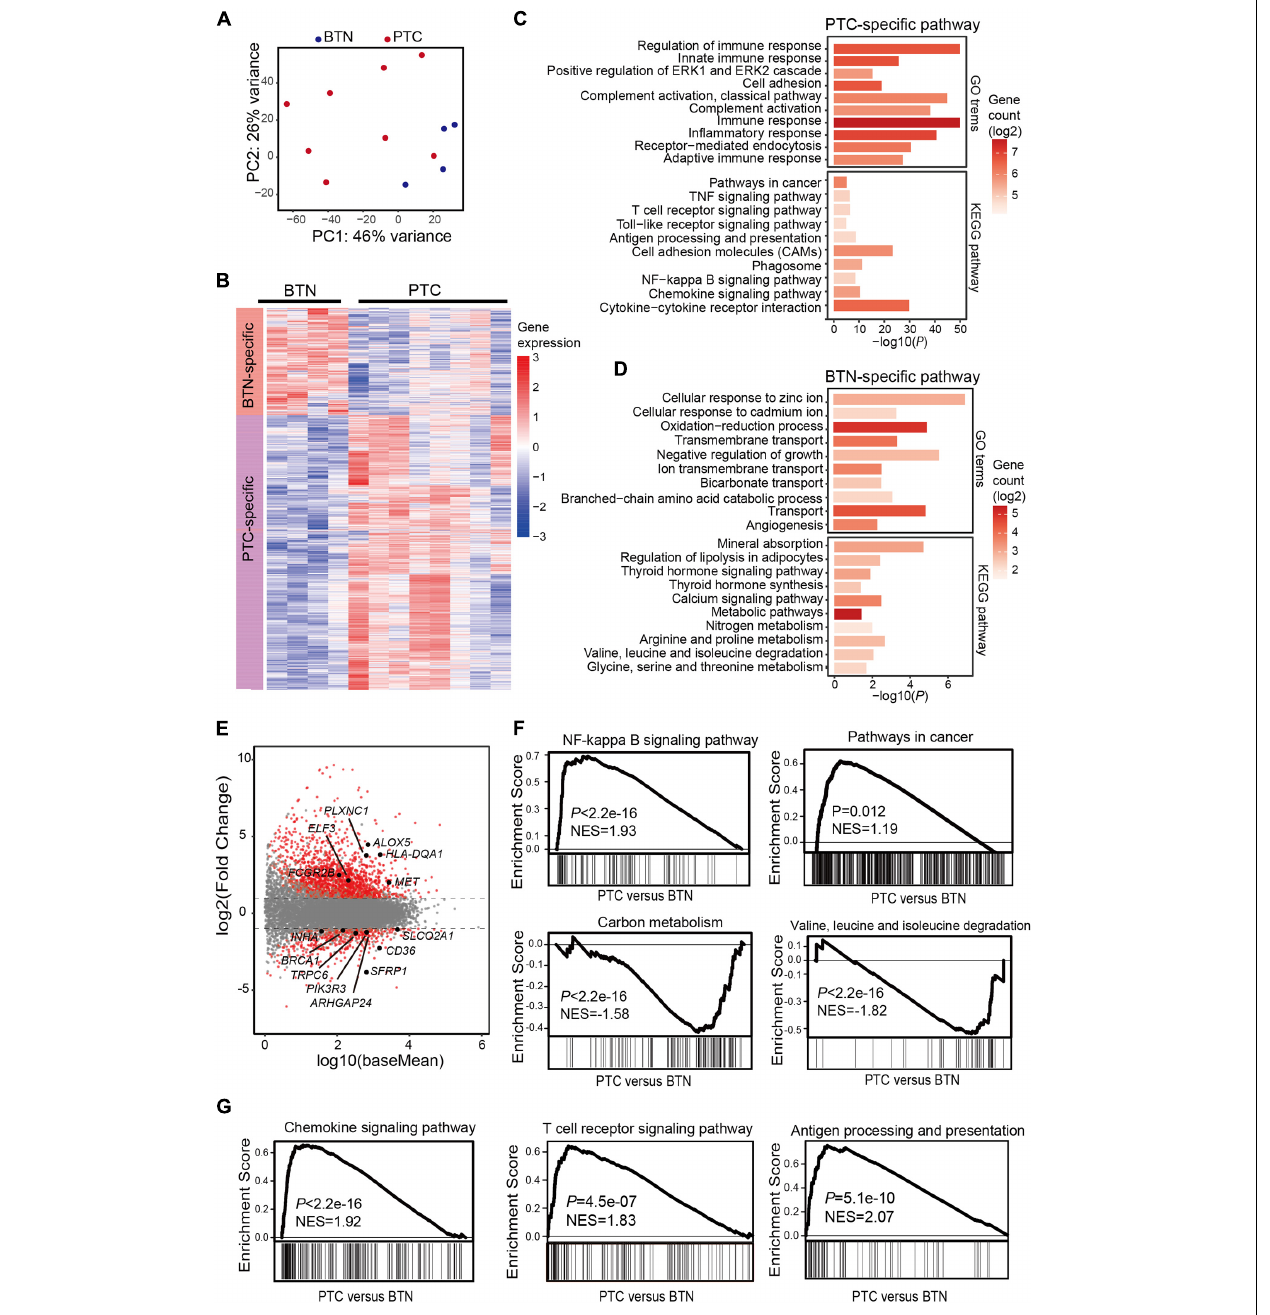
FIGURE 3 | Transcriptome characterization of PTC and BTN tissues. (A) Principal component analysis of transcriptomes in PTC and BTN. (B) Heatmap of gene expression values in PTC and BTN. (C,D) Enrichment analysis for GO terms and KEGG pathway. Top pathways for PTC-upregulated and BTN-upregulated genes are shown. (E) MA plot for differentiated analysis of gene expression between PTC and nodule tissues. The red plots at the upper side of the line represent PTC-specific genes, while plots at the opposite side represent nodule-specific genes. (F) GSEA plots indicated cancer-related and metabolism-related genes in PTC and BTN samples. (G) GSEA plots showed PTC-upregulated genes enriched in immune-related pathways. PTC, papillary thyroid carcinoma; BTN, benign thyroid nodule; GO, gene ontology; KEGG, Kyoto Encyclopedia of Genes and Genomes; GSEA, gene set enrichment analysis.